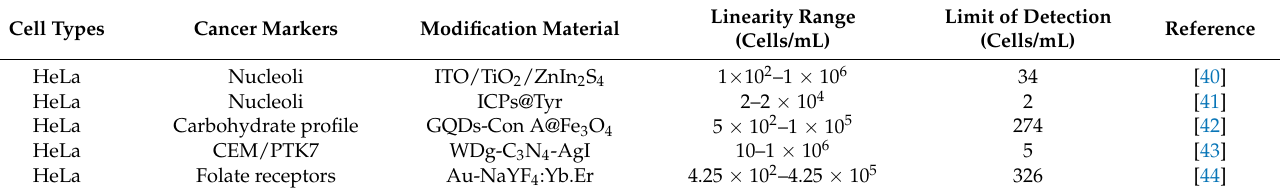
Table 3. Electrochemical used cytosensors for cervical cancer cell